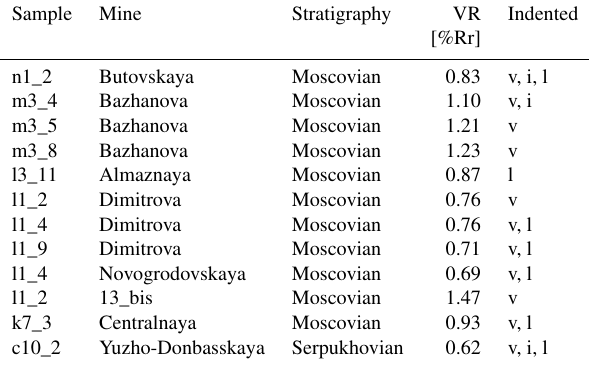
Table 1. List of samples including information on stratigraphic as- signment, measured vitrinite reflectance (VR) and indented maceral groups (v = Vitrinite; i = Inertinite; l = Liptinite). Sample Mine